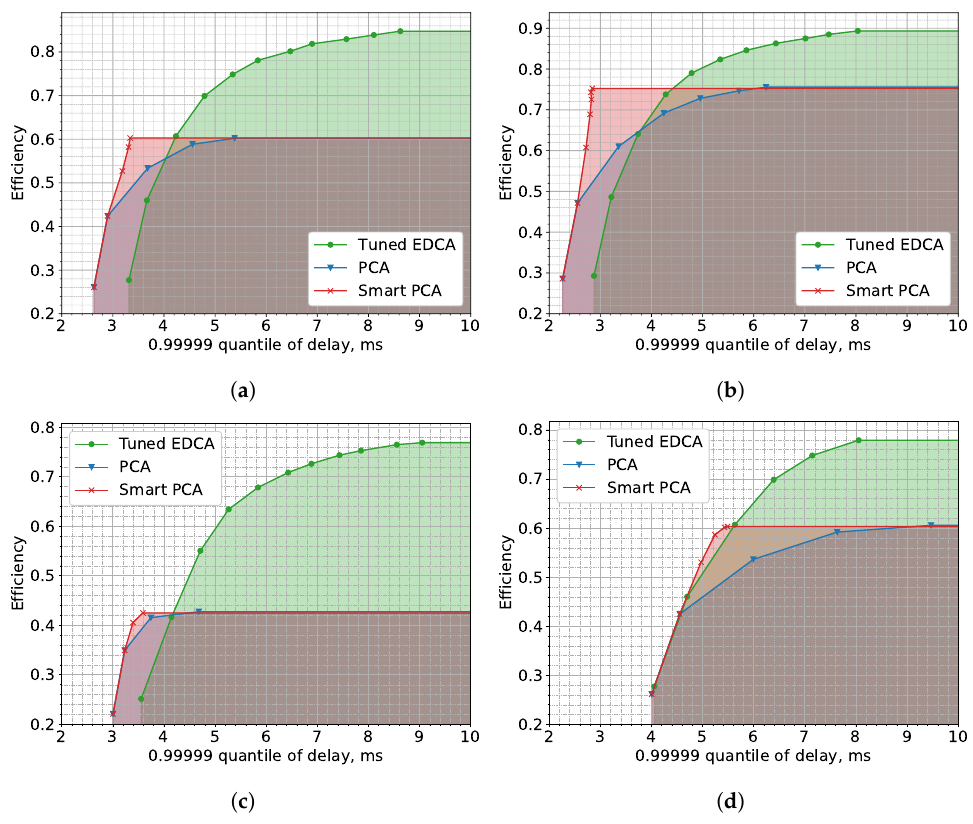
Figure 7. Dependences of the maximum efficiency on the provided delay quantile (part II). ( a ) T period = 20ms, σ = 10µs, M = 3. ( b ) T period = 50ms, σ = 10µs, M = 3. ( c ) T period = 10ms, σ = 10µs, M = 3. ( d ) T period = 100ms, σ = 10µs, M =